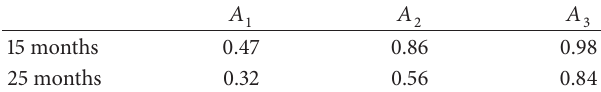
Table 14: Alternative weights during